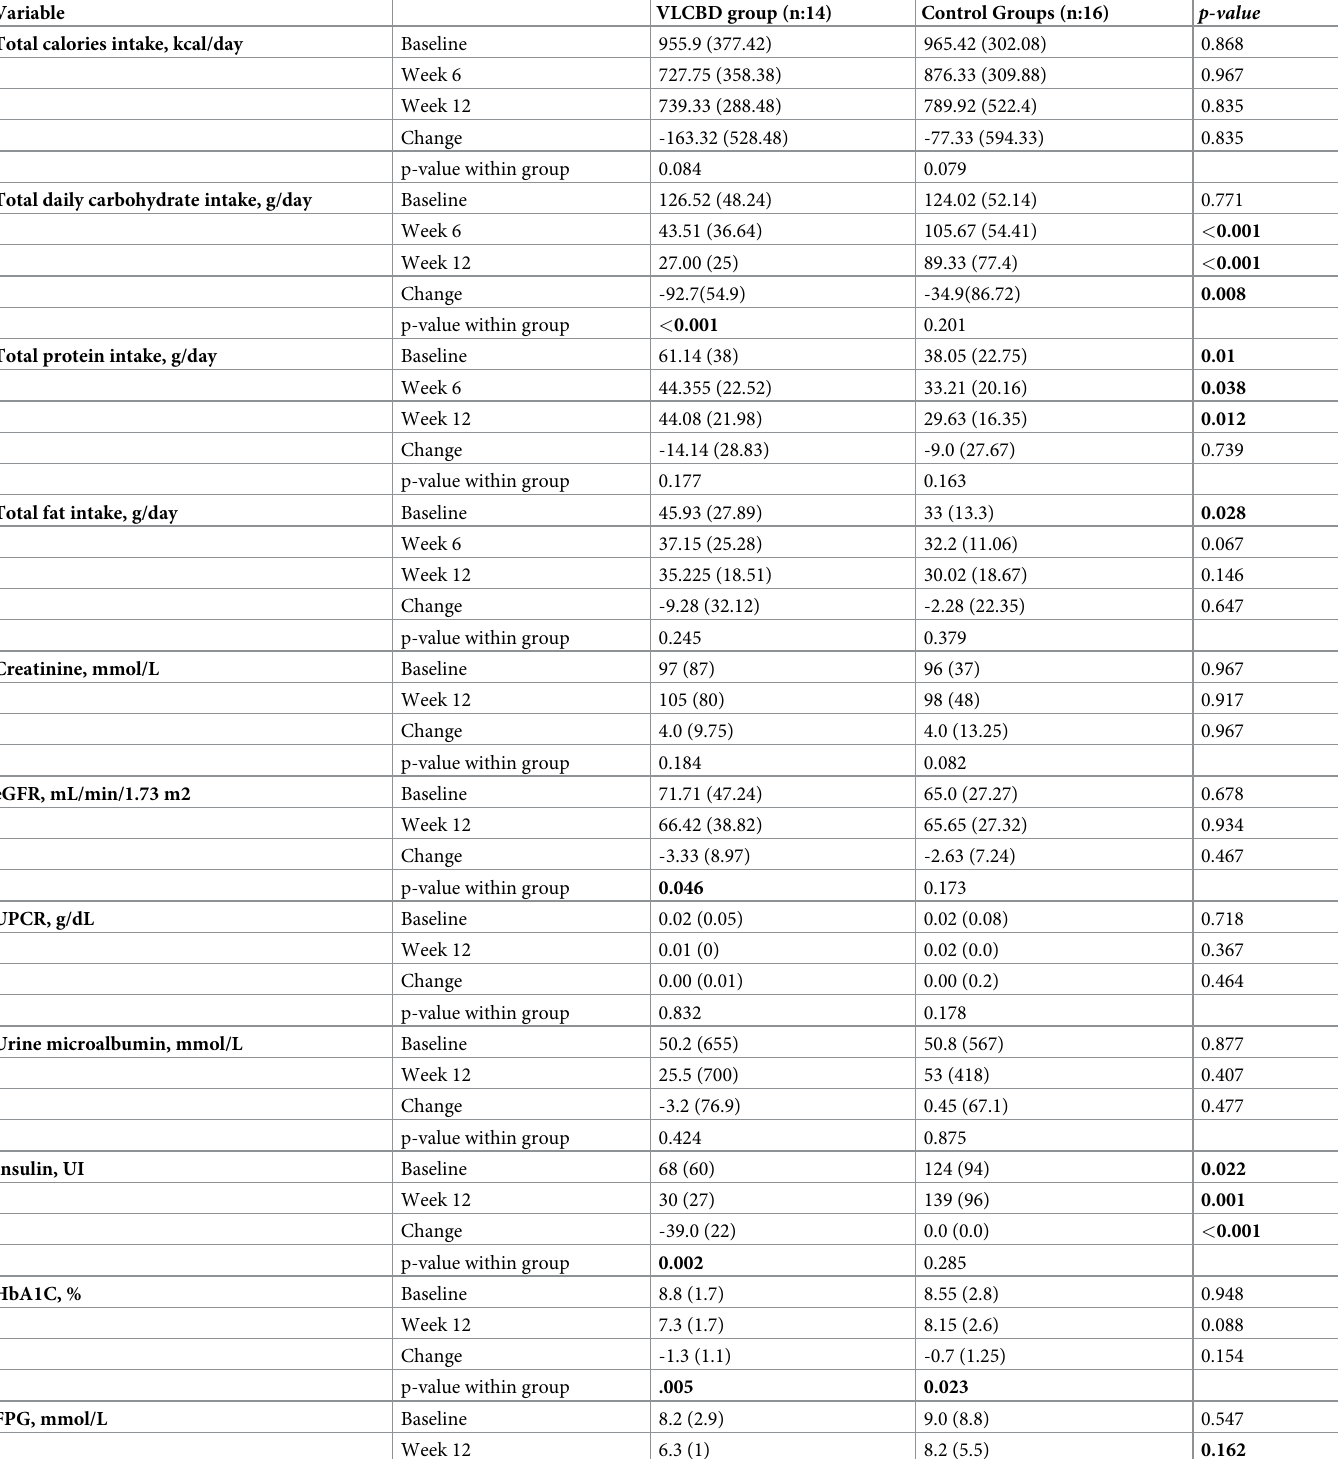
Table 2. Comparison of changes in renal outcome, insulin requirement, biochemical and inflammatory markers between the VLCBD and LPD groups over 12 weeks of